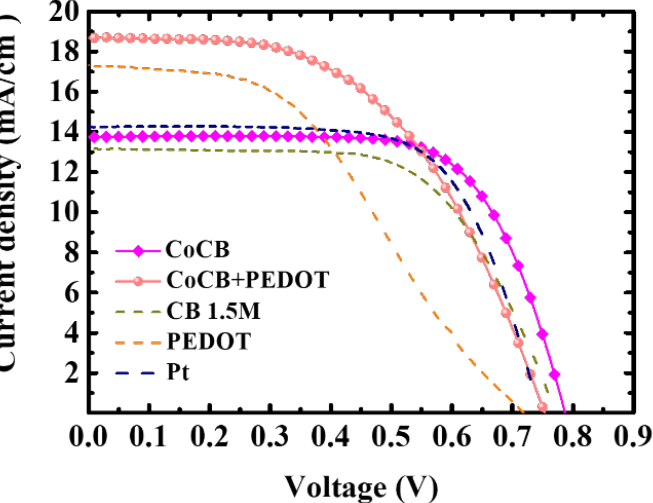
Figure 5. J–V characteristics of DSSCs with series of cobalt complex CEs. Table 3. Performance levels of DSSCs with cobalt complex CEs. The values in the brackets are the standard deviation.